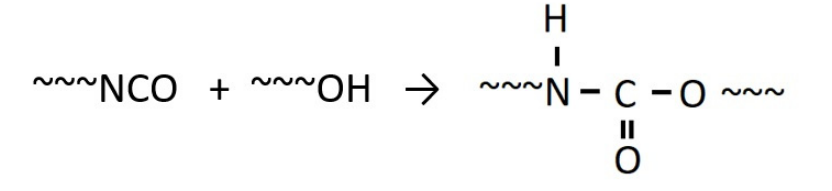
Figure 7. An example of a reaction occurring during the preparation of polyurethane